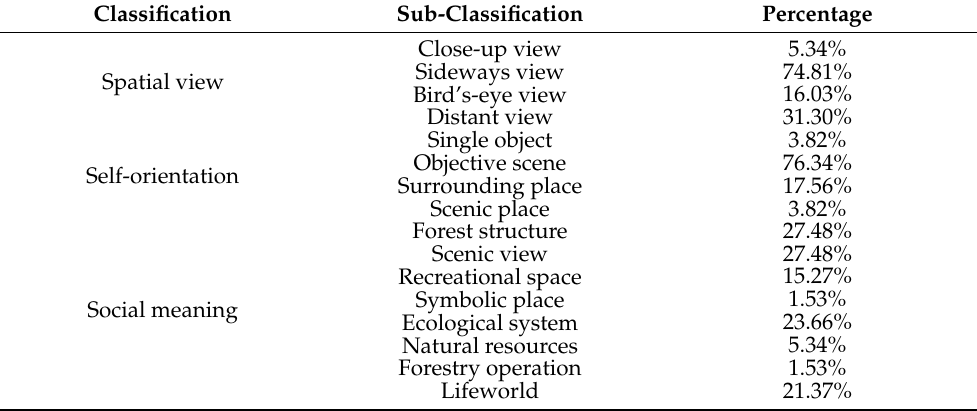
Table 2. Statistical data for spatial view, self-orientation, and social meaning in